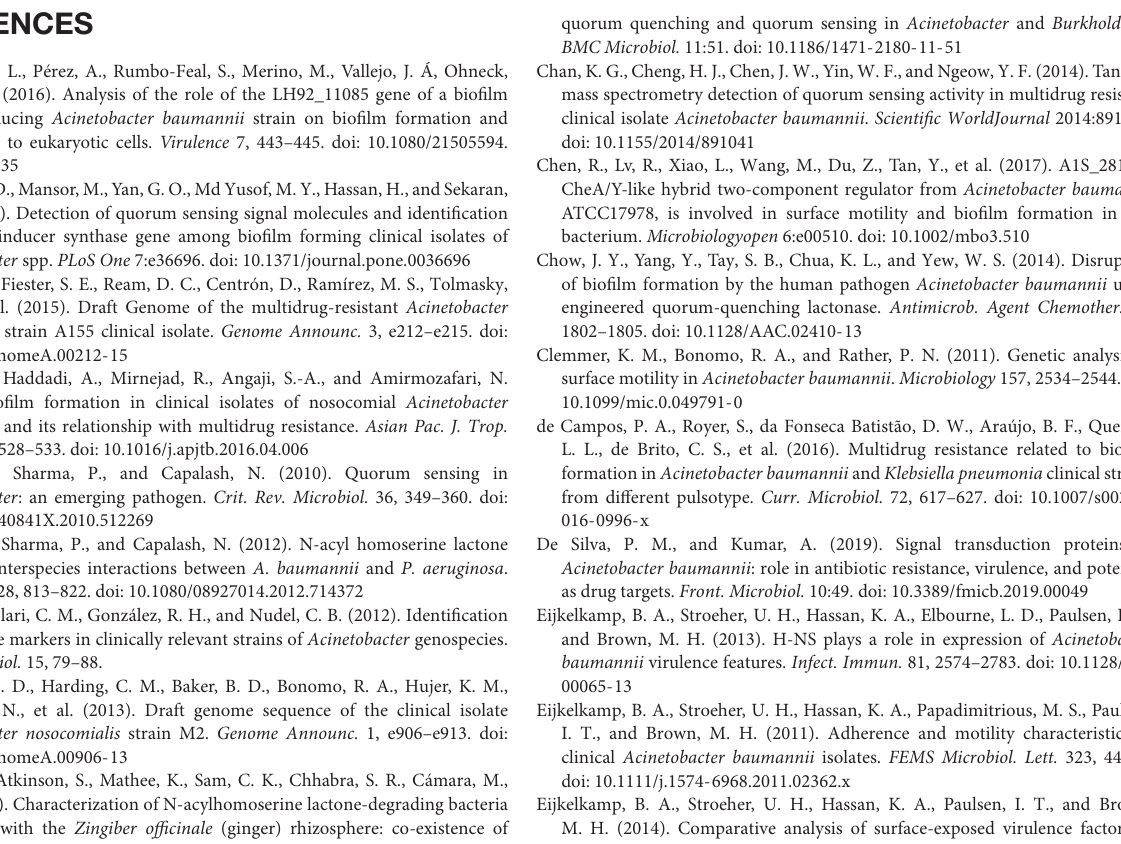
plates were incubated at 37 ◦ C for 14 h. Images are representative of three independent experiments carried out with three replicates per condition. Supplementary Figure 3 | Effect of osmolarity on surface-associated motility in A. baumannii ATCC R (cid:13) 17978 TM (A) and A. nosocomialis M2 (B) . Cells were inoculated on LB plates with different NaCl (0.1–0.4M) or sucrose (5–20%) concentrations. Plates were incubated at 37 ◦ C for 14 h. Images are representative of three independent experiments carried out with three replicates per condition. NaCl concentration in standard LB medium is 0.17M. Supplementary Figure 4 | Biofilm formation by A. baumannii ATCC R (cid:13) 17978 TM and its isogenic mutant (cid:49) abaI in LB (gray bars) and low-salt LB (LS-LB, NaCl 0.5%, white bars) culture media. Biofilms were formed on 18 mm × 18 mm glass coverslips using a modification of the Active Attachment model (Exterkate et al., 2010), incubated for 24 h at 37 ◦ C and quantified using the crystal violet assay. Values are shown as average ± SD ( n = 3). The asterisk shows statistically significant differences (Mann–Whitney test, p < 0.05) between LB and LS-LB. Supplementary Figure 5 | Effect of the QQ lactonase Aii20J (20 µ g/mL) on biofilm formation by A. baumannii ATCC R (cid:13) 17978 TM , the A. baumannii clinical strain MAR002, which was reported to be a biofilm hyper-former, its isogenic mutant (cid:49) 11085, which was reported to be defective in biofilm formation and eukaryotic cell attachment in comparison with the parental strain (Álvarez-Fraga et al., 2016) and A. nosocomialis M2. (A) Biofilm quantification using the Crystal Violet staining method. Values are averages ± SD ( n = 3). The asterisks show statistically significant differences (Mann–Whitney test, p < 0.05) between treated and untreated biofilms for the same strain. (B) Pictures showing the aspect of the untreated (left) and treated (right) biofilms stained with crystal violet. Biofilms were produced on 18 mm × 18 mm glass coverslips using a modification of the Amsterdam Active Attachment model (Exterkate et al., 2010) in LS-LB, incubated for 24 h at 37 ◦